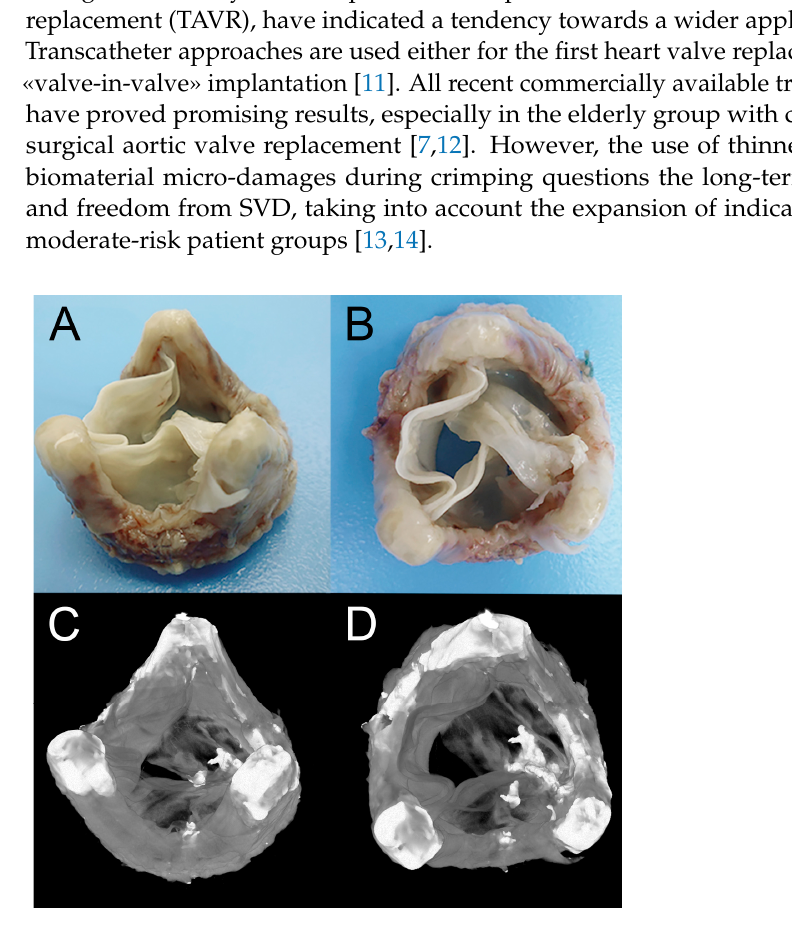
Figure 1. Explanted biological heart valve with degenerative changes (signs of fibrosis and calcification), ( A )—outflow portion (isometric view), ( B )—outflow portion (top view), ( C )—microtomographic projection of outflow side (isometric view), ( D )—microtomographic projections of outflow side (top view).